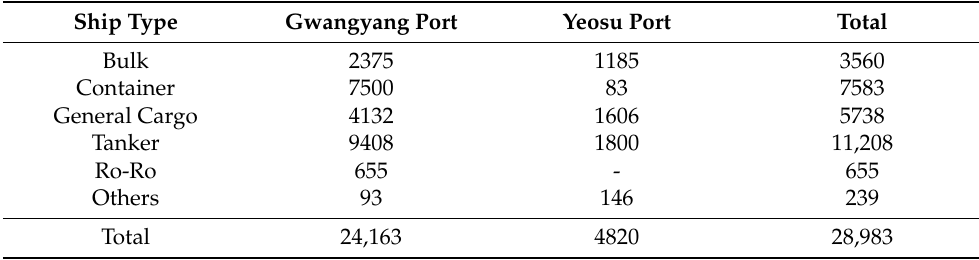
Table 2. The number of ship calls by ship types at Yeosu and Gwangyang ports in 2019. (Unit: ship